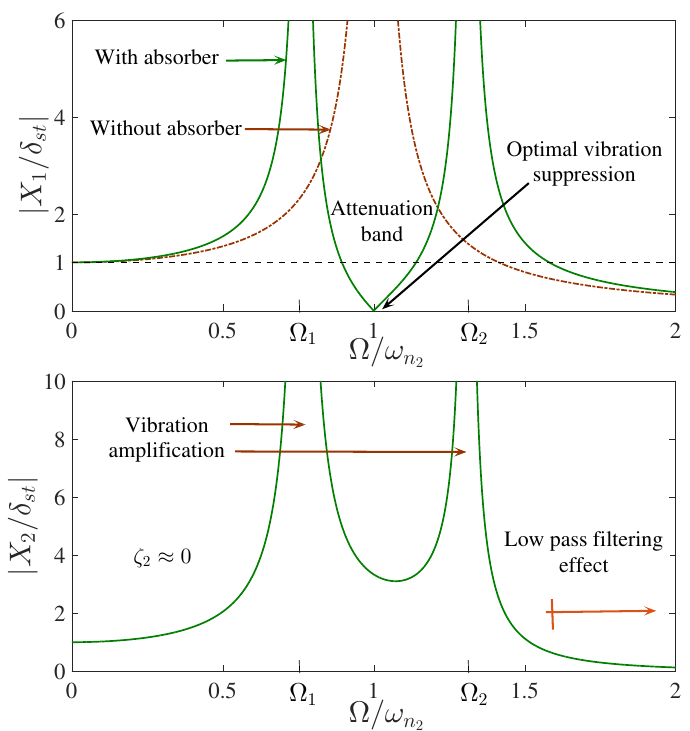
Figure 1. Frequency response functions of the flexible mechanical system with a passive dynamic vibration absorber. Primary system ( top ), Tuned Mass Damper ( bottom